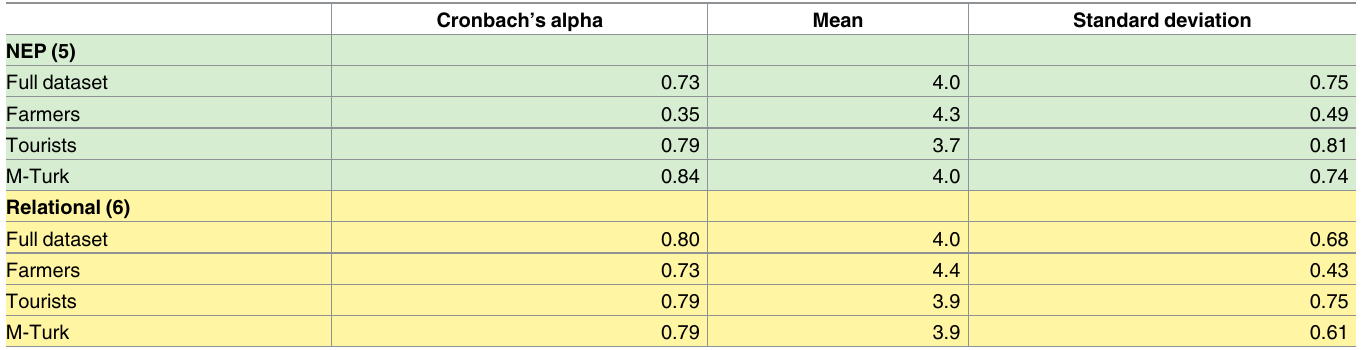
Table 4. Cronbach’s alpha, mean response and standard deviation of responses across value